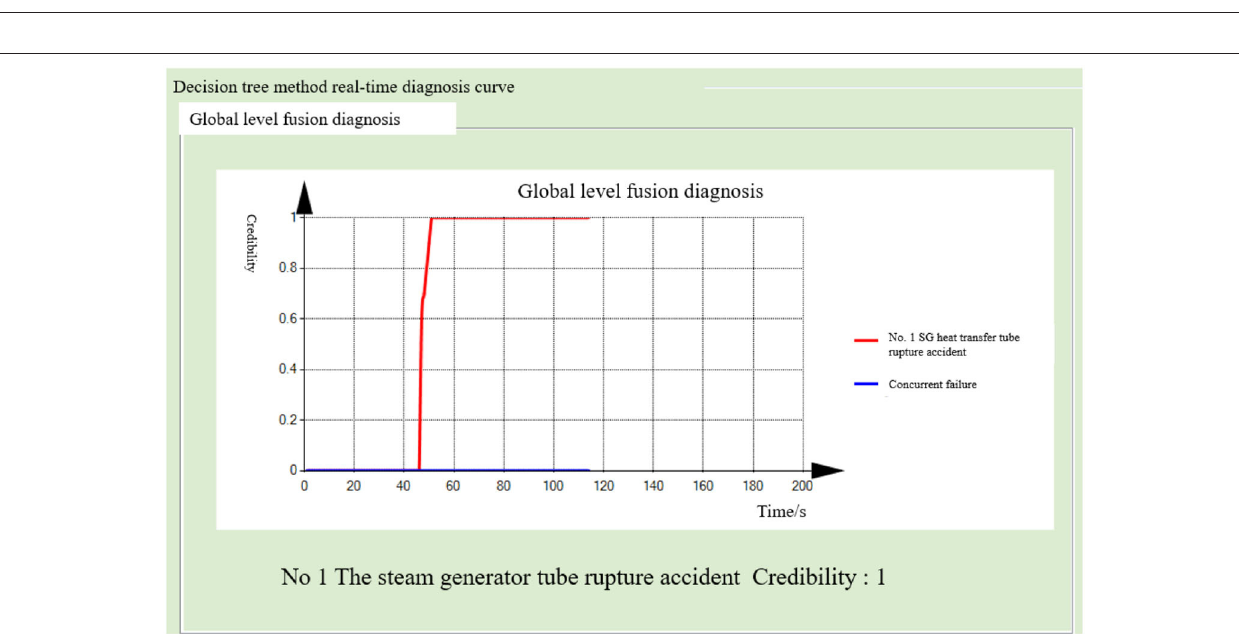
FIGURE 16 | Real-time diagnosis results of the main water supply system (decision tree method).